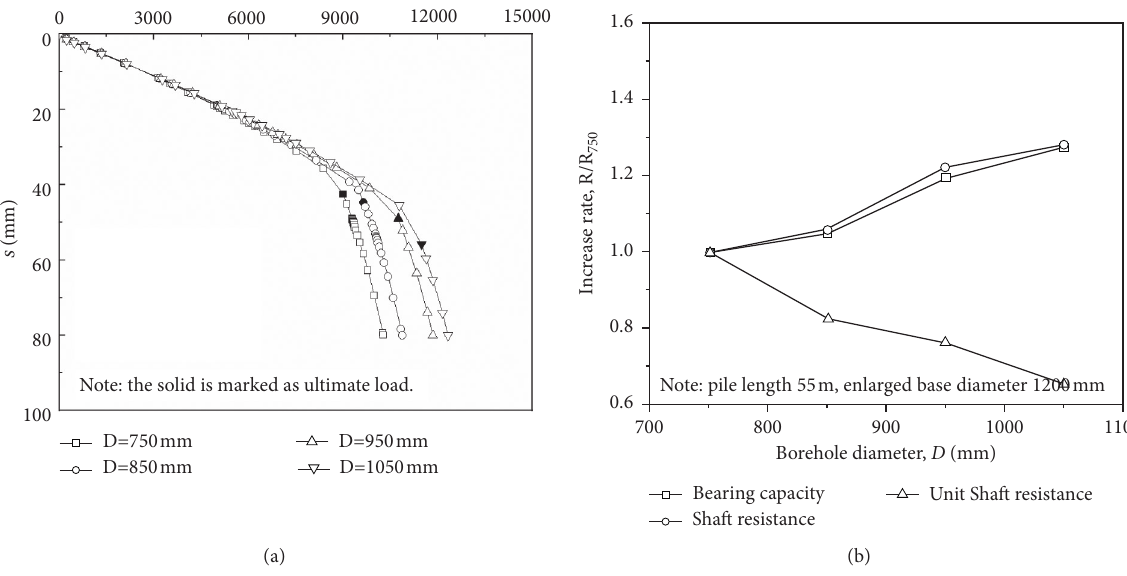
Figure 15: Influence of the thickness of cement soil (diameter of the borehole) on bearing capacity. (a) Comparison of bearing capacity. (b) Efficiency